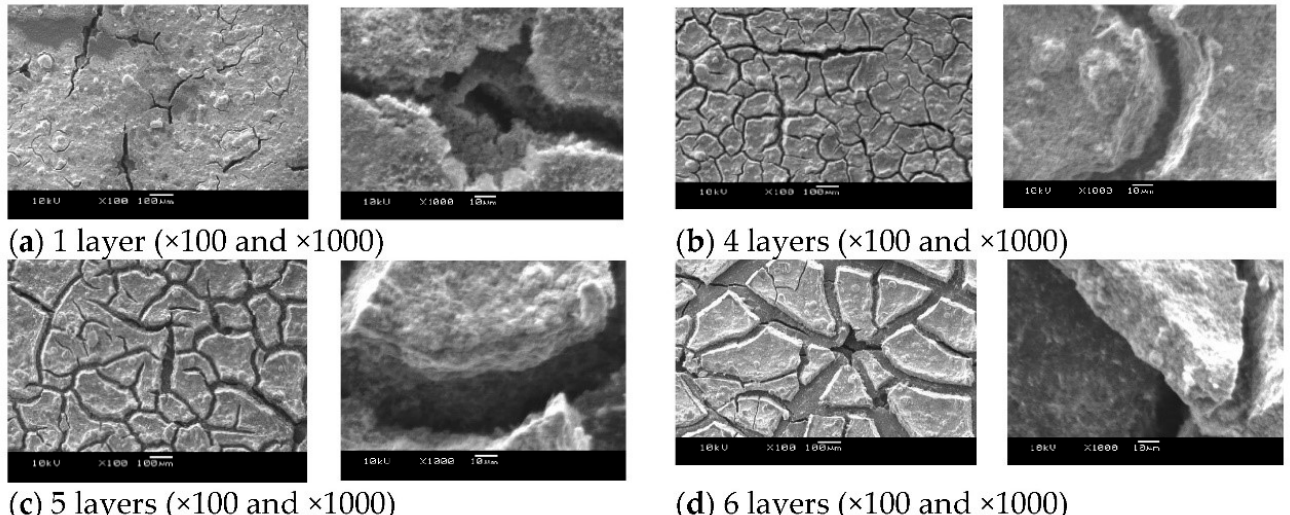
Figure 7. Comparison of SEM image of the surface of each CL.